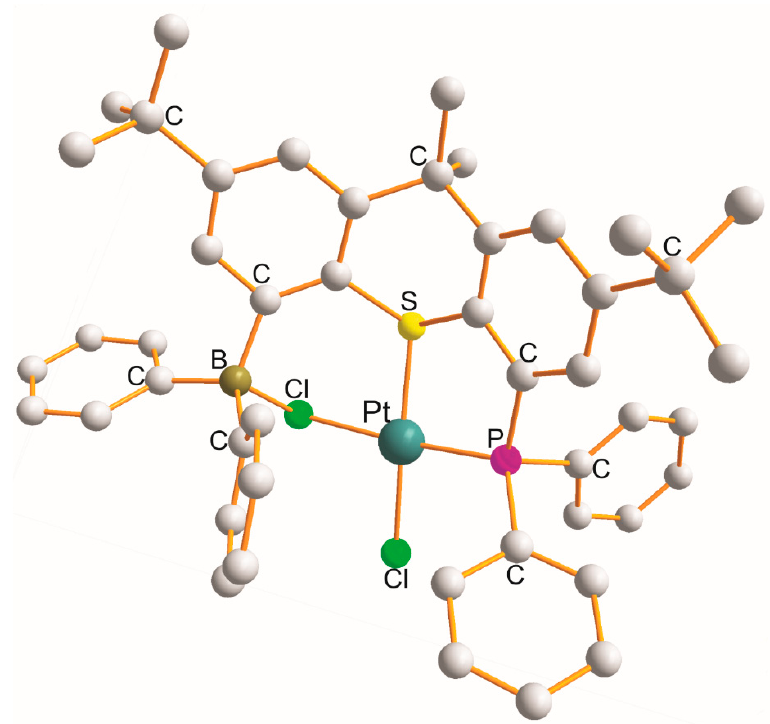
Figure 4. Structure of Pt{ κ 3 –Ph 2 P 1 (C 23 H 28 S 1 )(B)(Ph 2 )Cl 1 }(Cl)] [27].